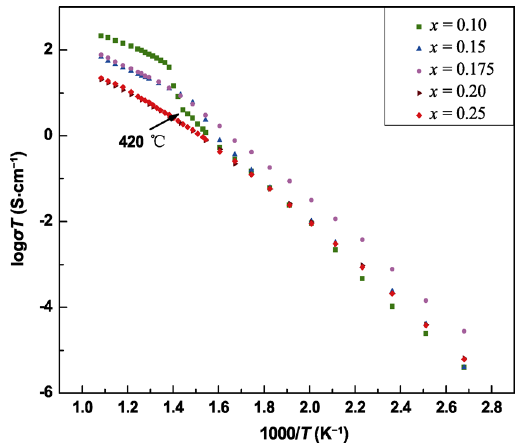
Fig. 8 Temperature dependence of conductivity for different dopant